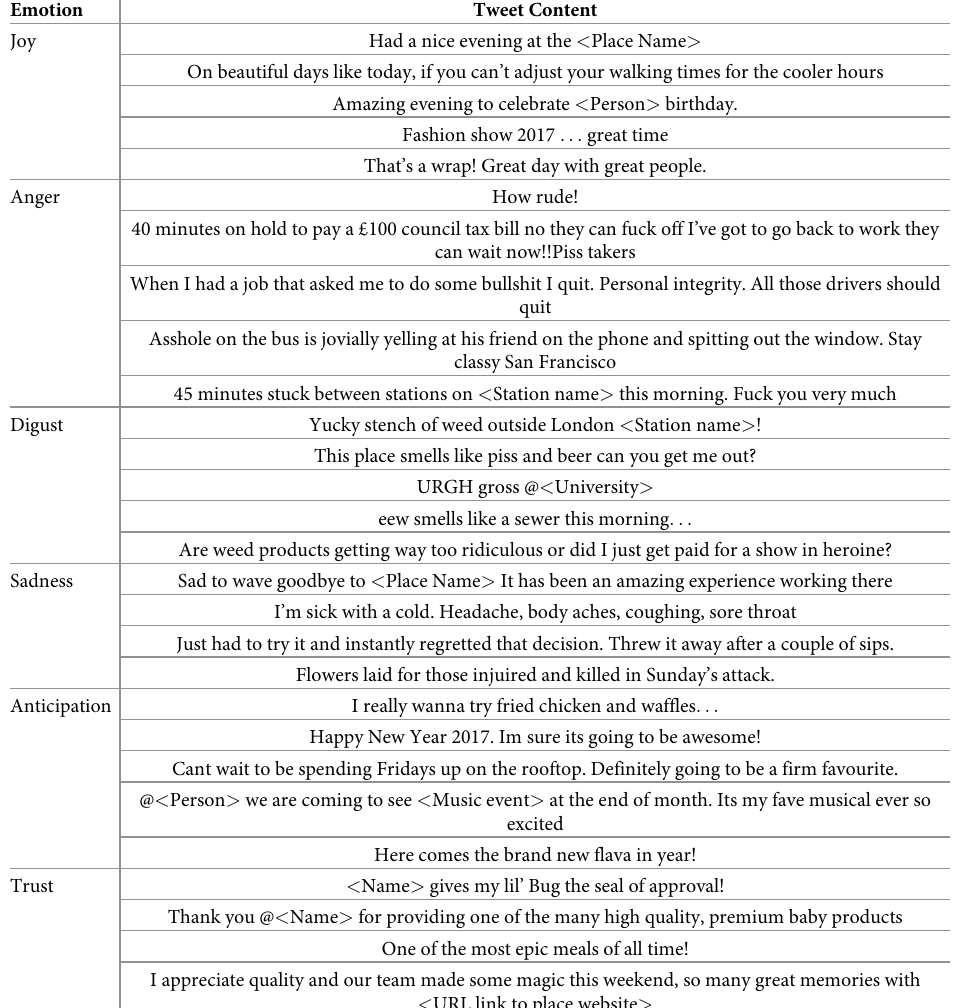
Table 2. Examples of tweets classified for each emotion in London and San